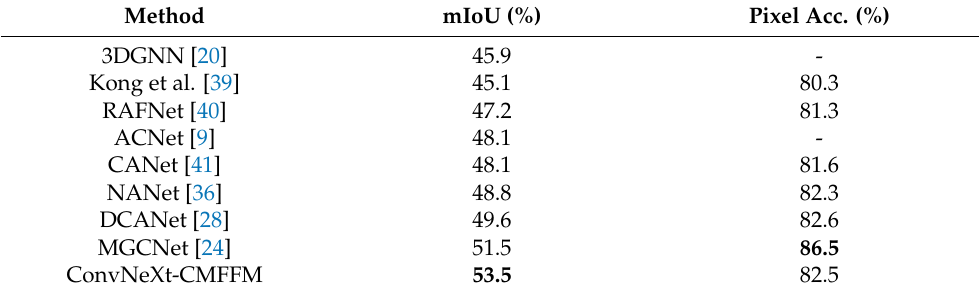
Table 3. Comparison with the state-of-the-art models on the SUN-RGBD dataset (the top ones are marked in bold).